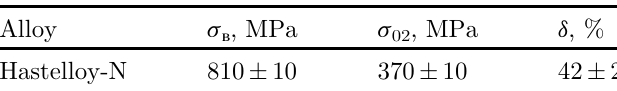
Table 3. Strength properties of Hastelloy-N alloy.